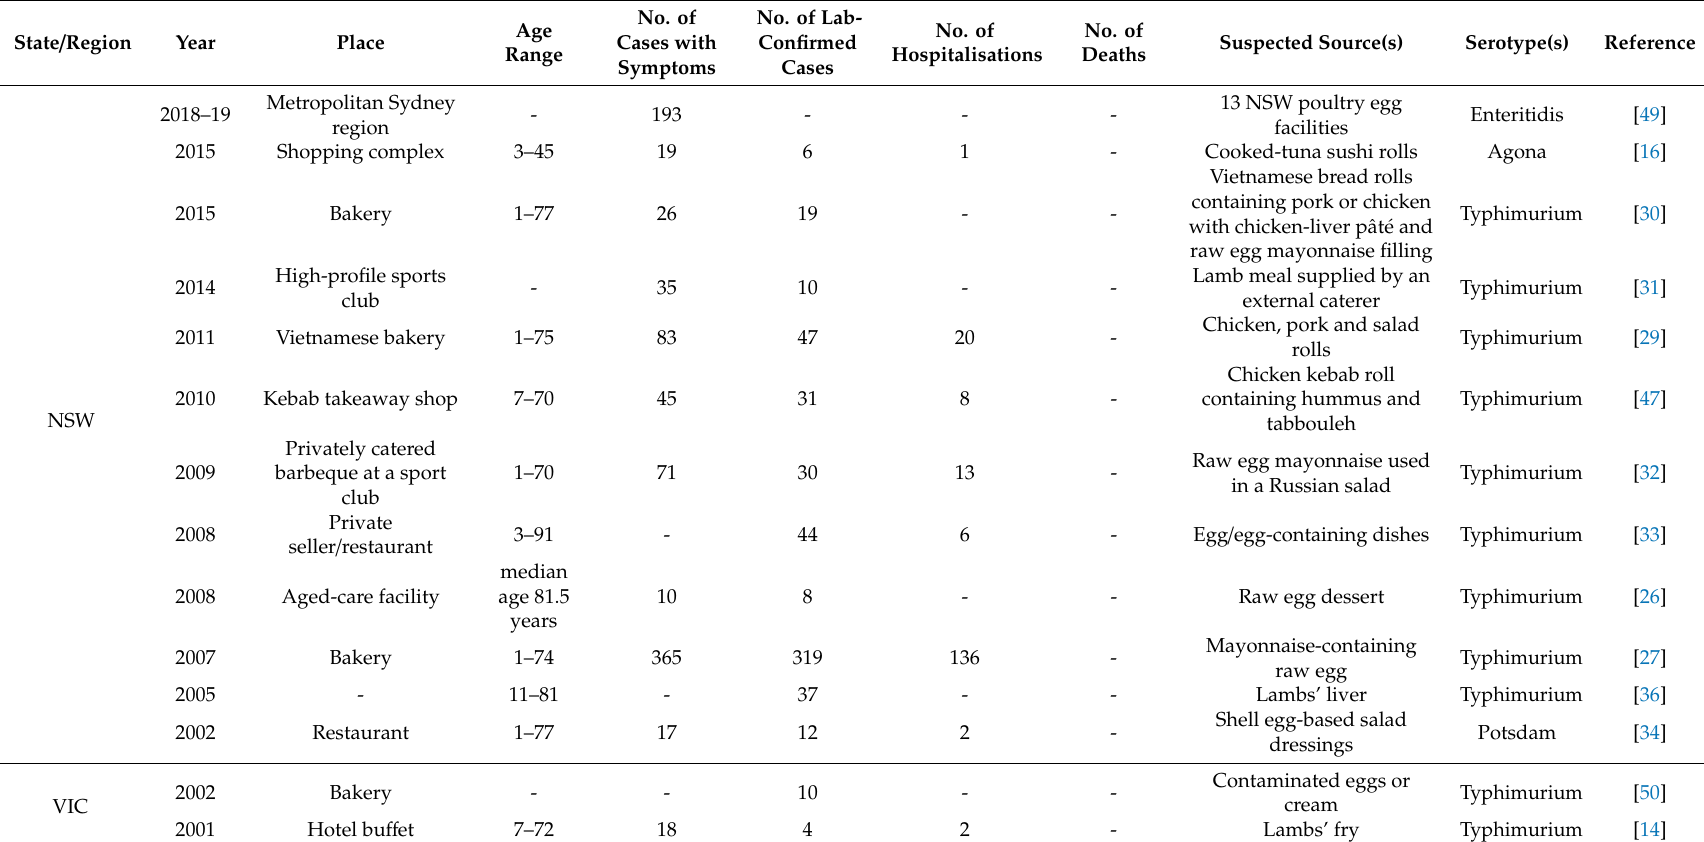
Table A1. Human salmonellosis outbreaks caused by suspected food of animal origin in